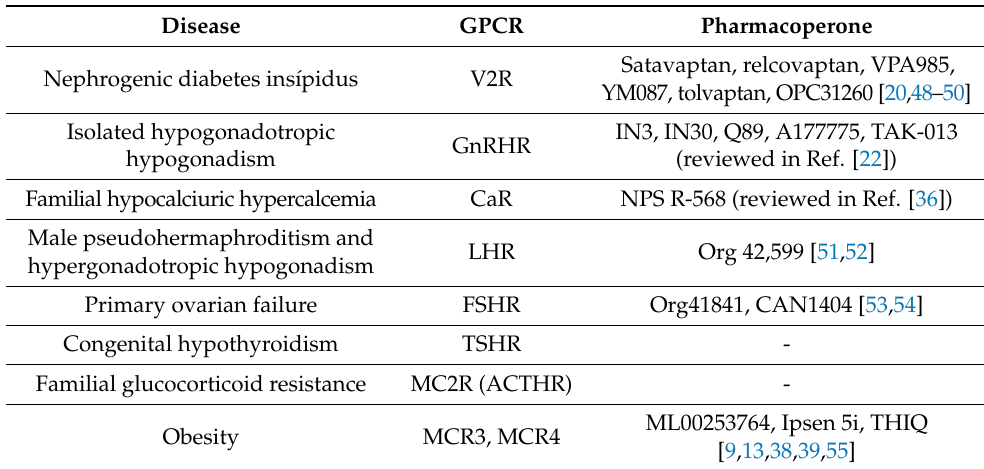
Table 1. Loss-of-function diseases caused by folding defects in GPCRs associated with endocrine function and pharmacological chaperones to correct folding and trafficking in vitro or in